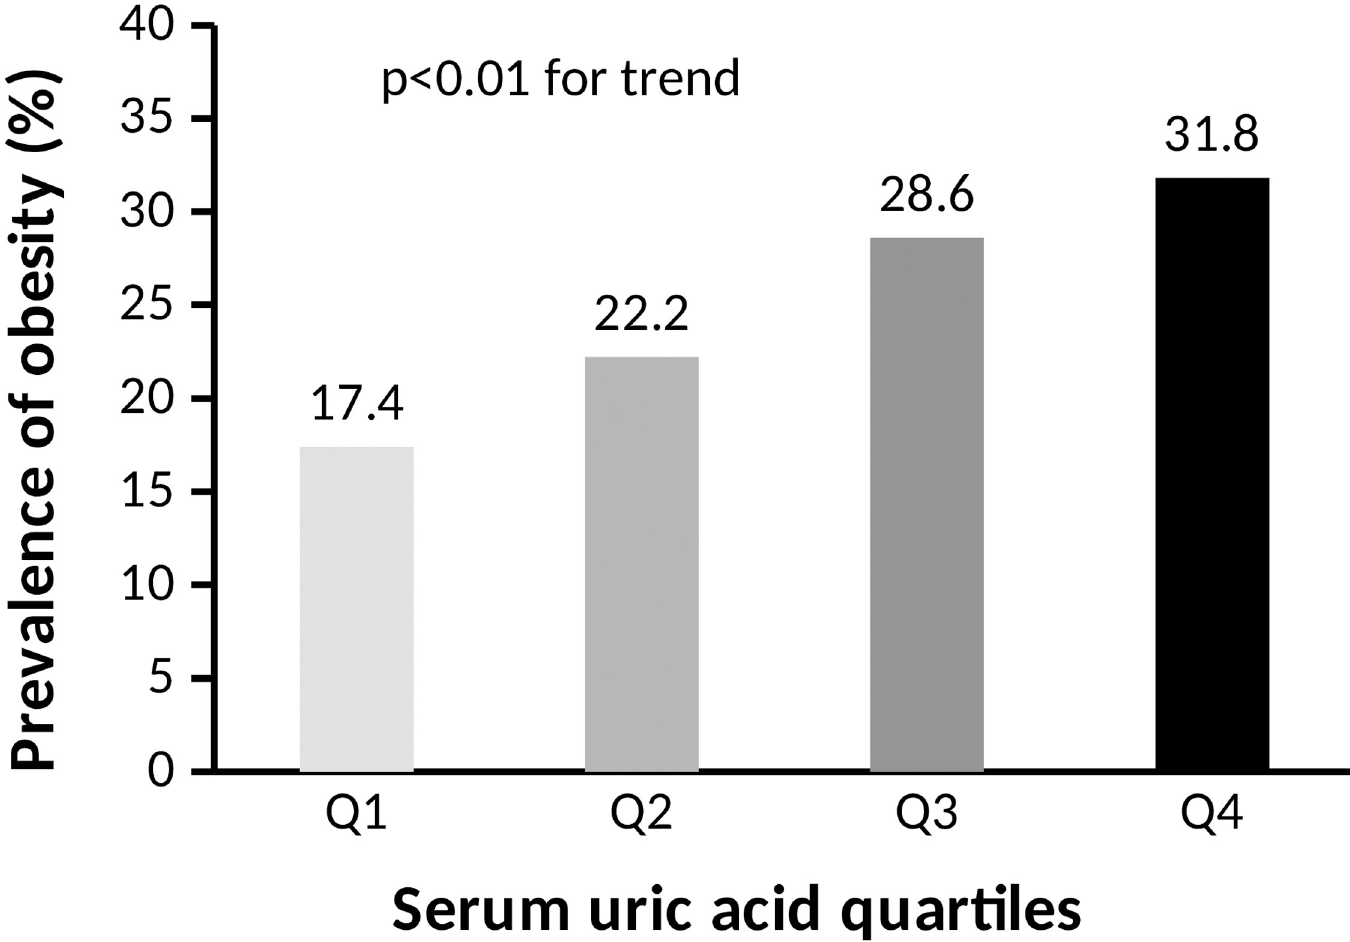
Fig 3. Comparison of obesity between the SUA quartile groups.